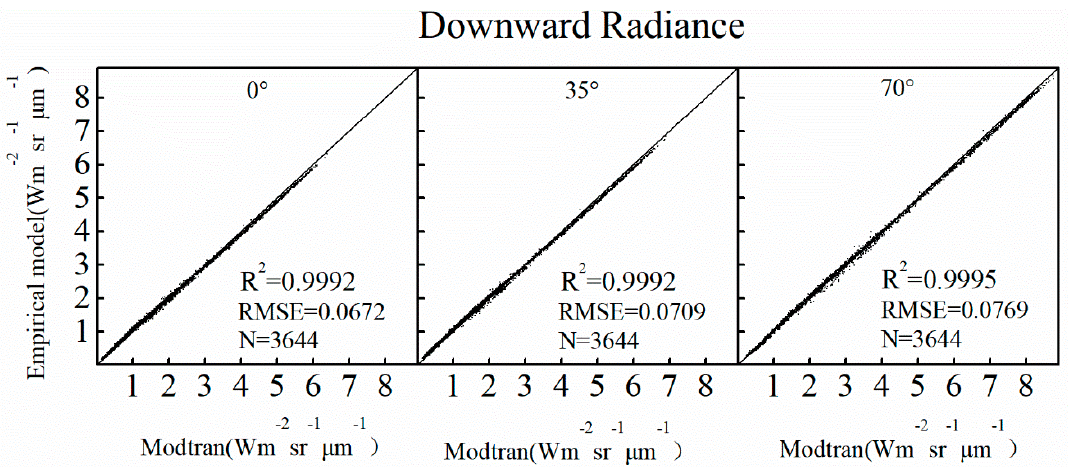
Figure 9. Comparison between Modtran and the empirical model-derived downward radiance for FLIR T420 thermal imager.